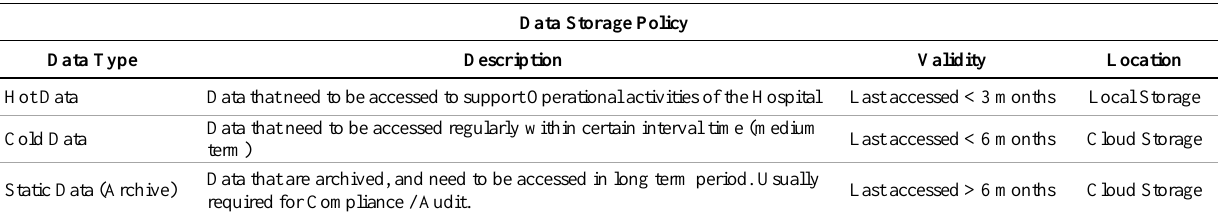
Table 2. Target Data Policy for Cloud